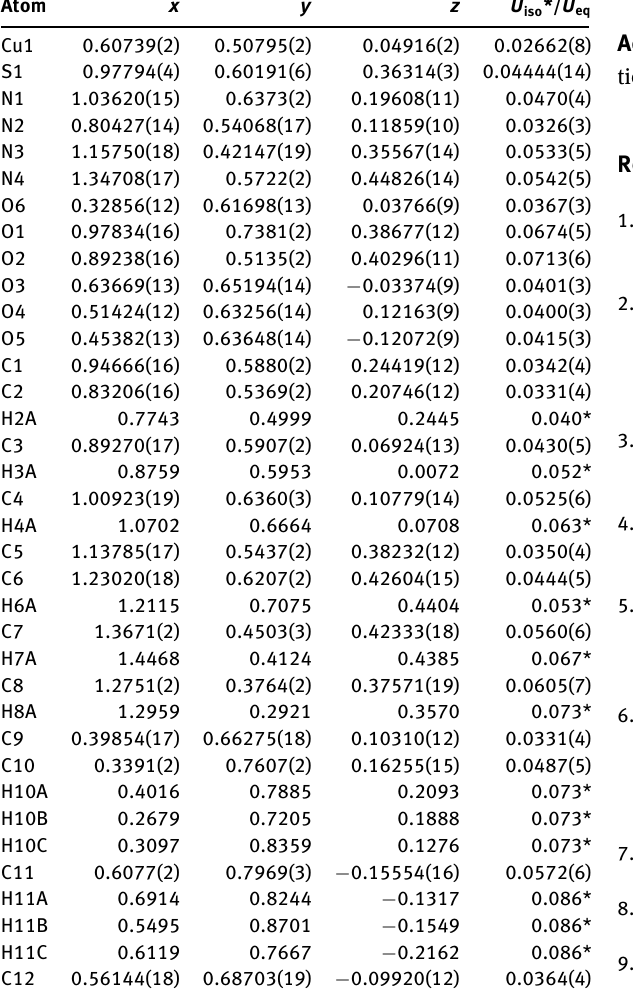
Table 2: Fractional atomic coordinates and isotropic or equivalent isotropic displacement parameters (Å 2